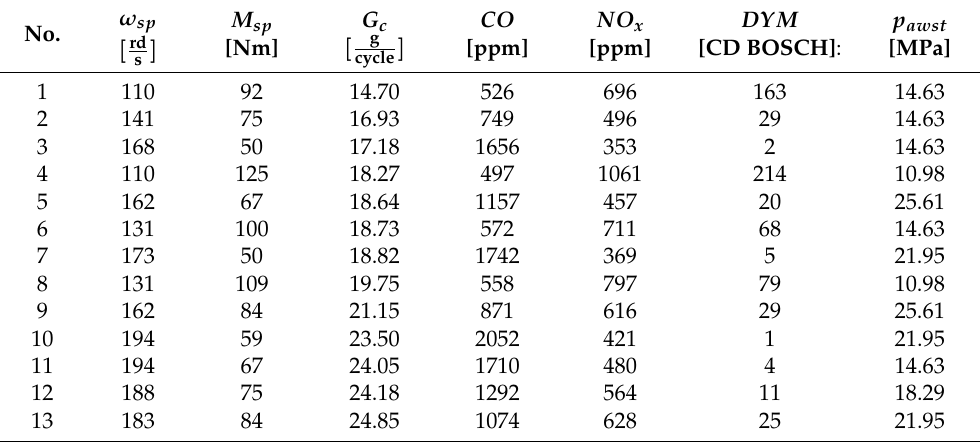
Table 1. Parameters of combustion engine duty points determined for accumulator with capacity V a = 0.005 [m 3 ] (load